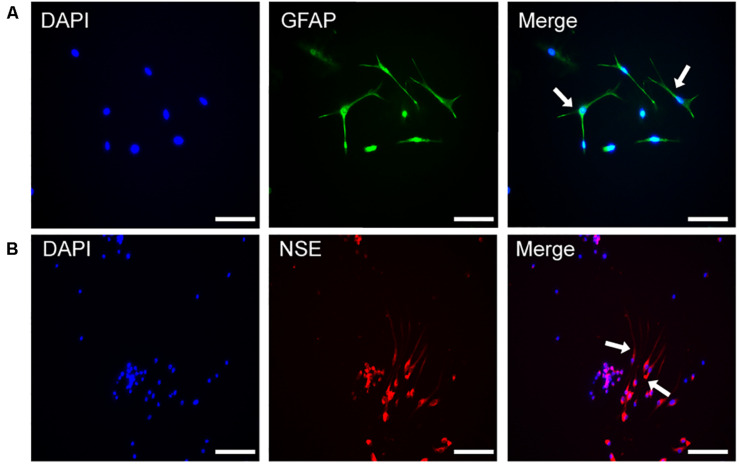
The identification of NSCs by immunofluorescence. (A) Immunofluorescence of DAPI and GFAP in the differentiated NSCs. (B) Immunofluorescence of DAPI and NSE in the differentiated NSCs, Scale bar: 25 μm.